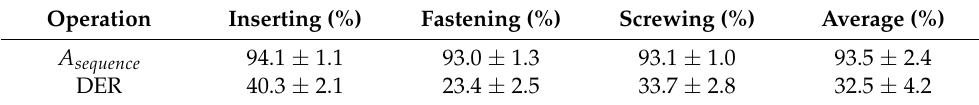
Table 7. The recognition accuracy of Augmented Reality assisted assembly training